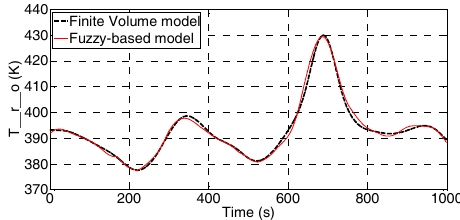
Figure 14. Comparison of evaporator outlet temperature of fuzzy-based and FV models.